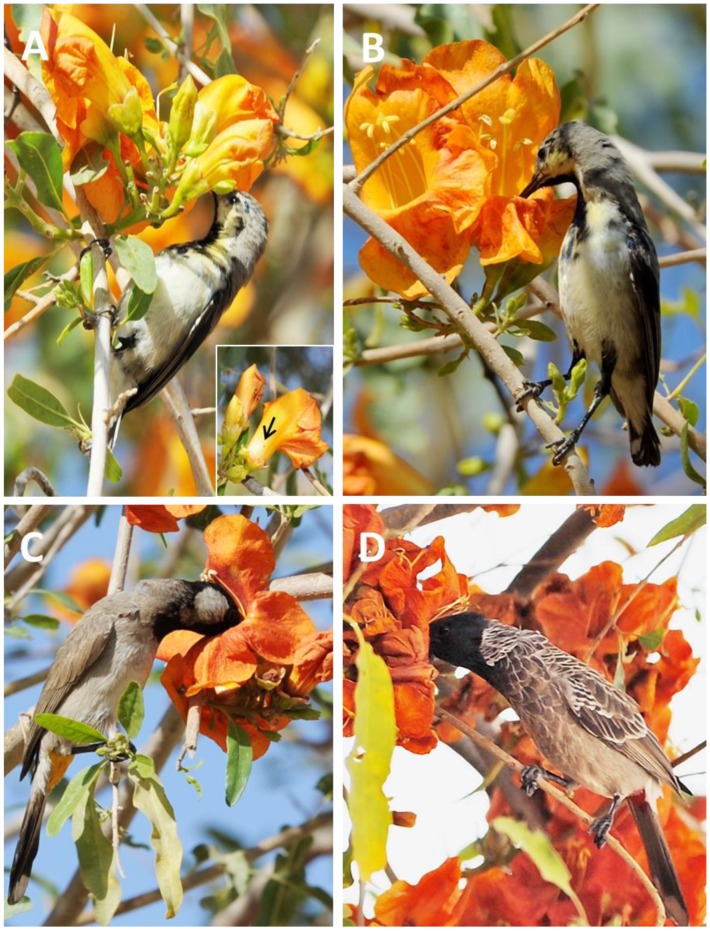
Robber and pollinators of T. undulata.(A) The robber (Nectarinia asiatica) consuming nectar by piercing through the corolla tube, and (B) through the opening of the tube. (C & D) The two pollinators - Pycnonotus leucotis and Pycnonotus cafer legitimately forage the flowers and facilitate pollination. Inset of (A): Note the hole (arrow) in the corolla tube made by the robber.